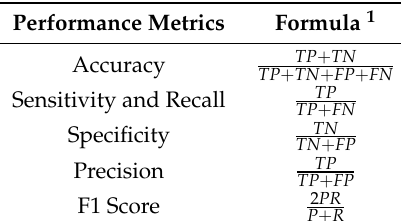
Table 4. Performance metrics.